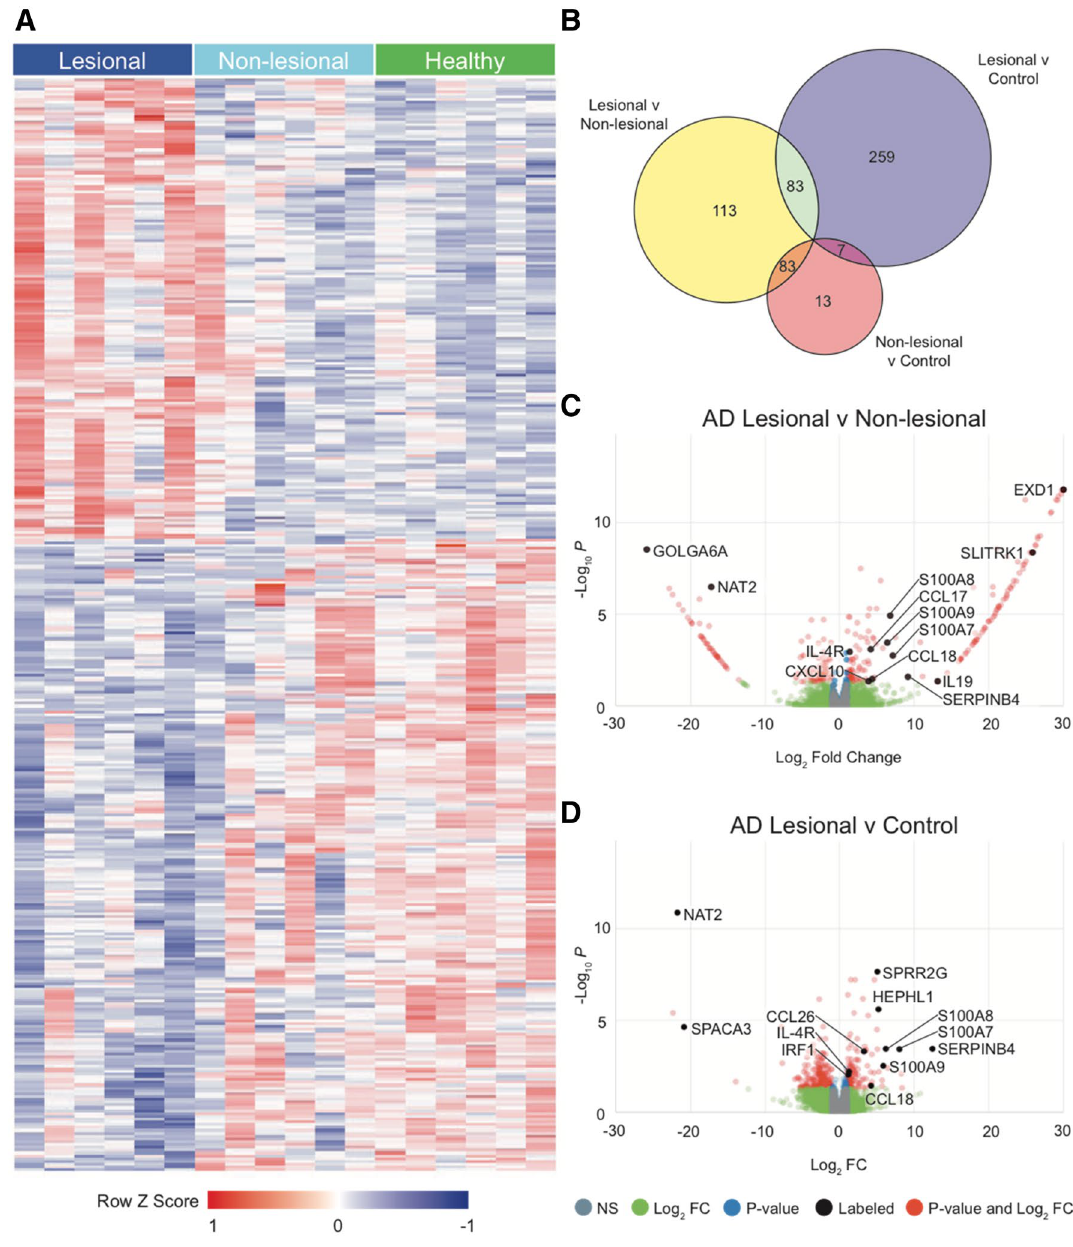
Figure 2. ( A ) Heatmap of gene expression by RNA-seq for differentially expressed genes (DEGs) between AD lesional vs. matched healthy control samples, where red is higher expression and blue is lower expression; DEGs defined as genes with a log base two fold change value less than -1 or greater than 1 and FDR adjusted p-value less than 0.05. ( B ) Venn diagram of DEGs for AD lesional samples, AD non-lesional samples, and matched healthy control samples. ( C ) AD lesional vs. non-lesional volcano plot. ( D ) AD lesional vs. control volcano plot. NS: not significant, FC: fold change, Log2FC: significant by Log2FC greater than 1 or less than − 1, p-value : significant by adjusted p-value < 0.05; p-value and Log2FC : significant by both adjusted p-value < 0.05 and Log2FC greater than 1 or less than − 1; heatmap was created with R version 4.0.2 (R Statistical Software) using the pheatmap package (https:// cran.r- proje ct. org/ web/ packa ges/ pheat map/ index.